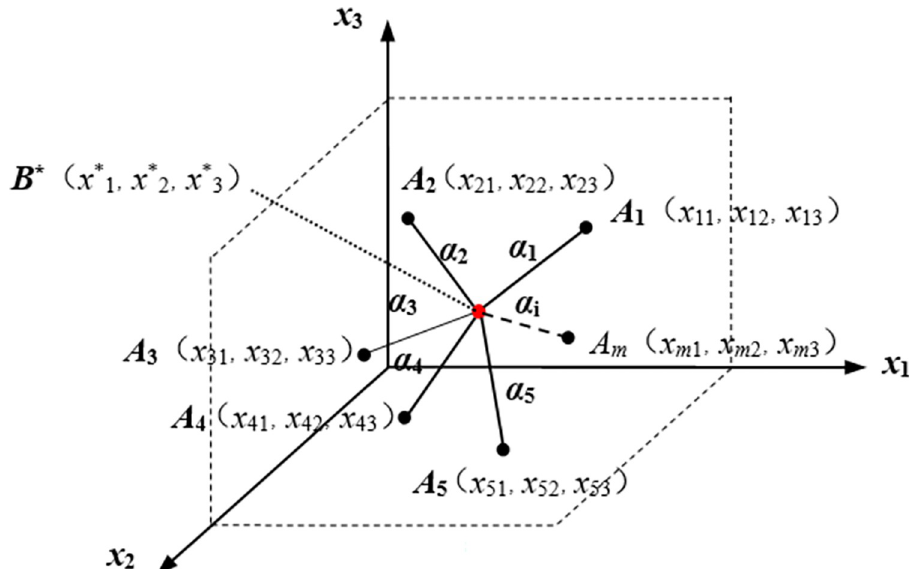
Fig 1. The three-dimensional space Fermat-Torricelli